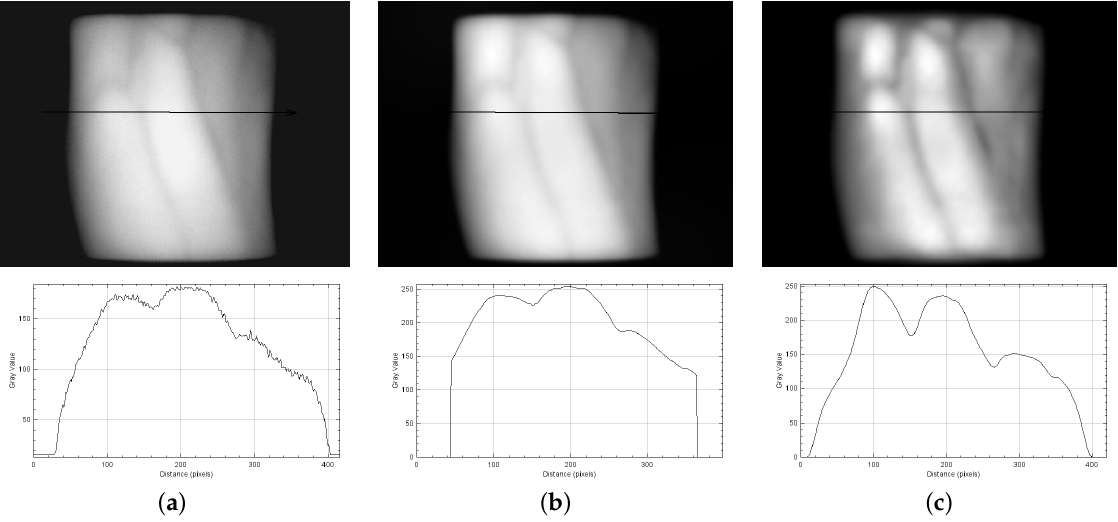
Figure 2. Preprocessing steps. ( a ) Original image and its profile; ( b ) inhomogeneity-corrected image and profile; ( c ) CLAHE image and corresponding